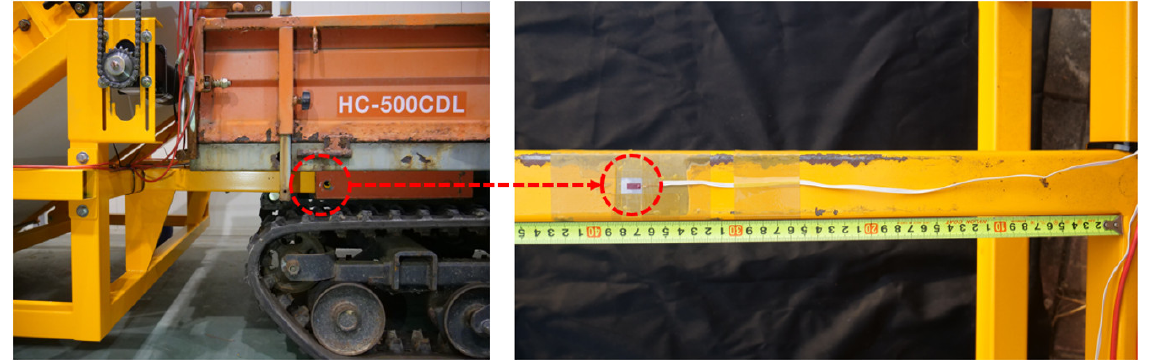
Figure 6. Configuration of measurement system.